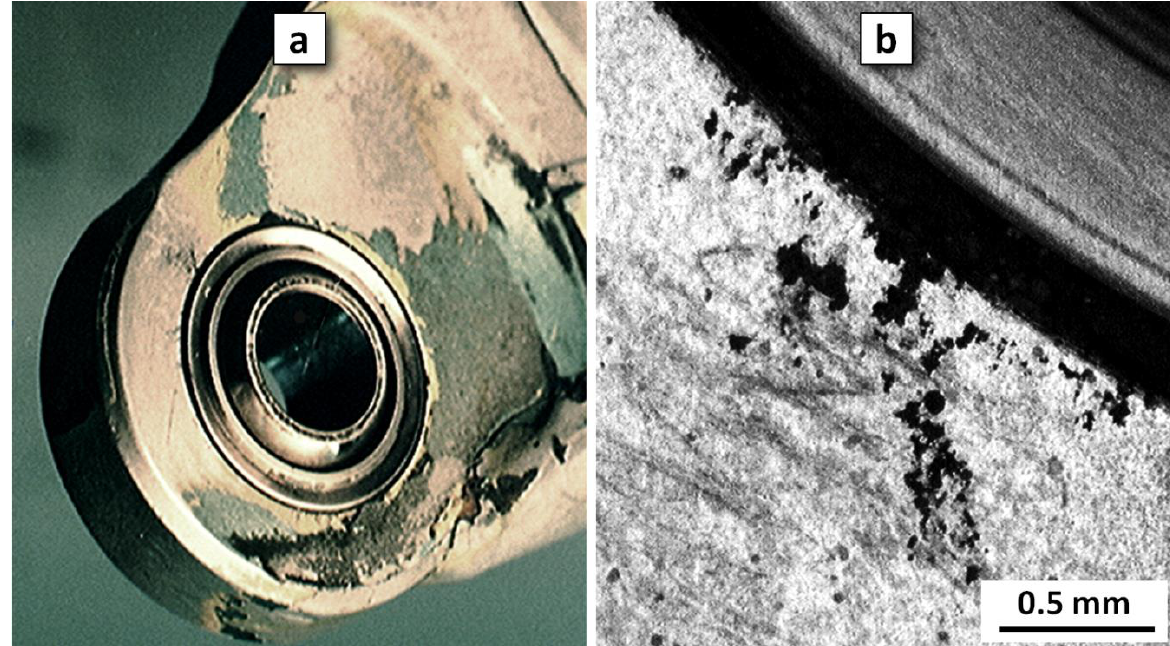
Figure 12. ( a ) View of a service-corroded AA7050-T73652 TEF hinge lug and stainless steel monoball; ( b ) examples of pitting corrosion in a lug bore, from [46].